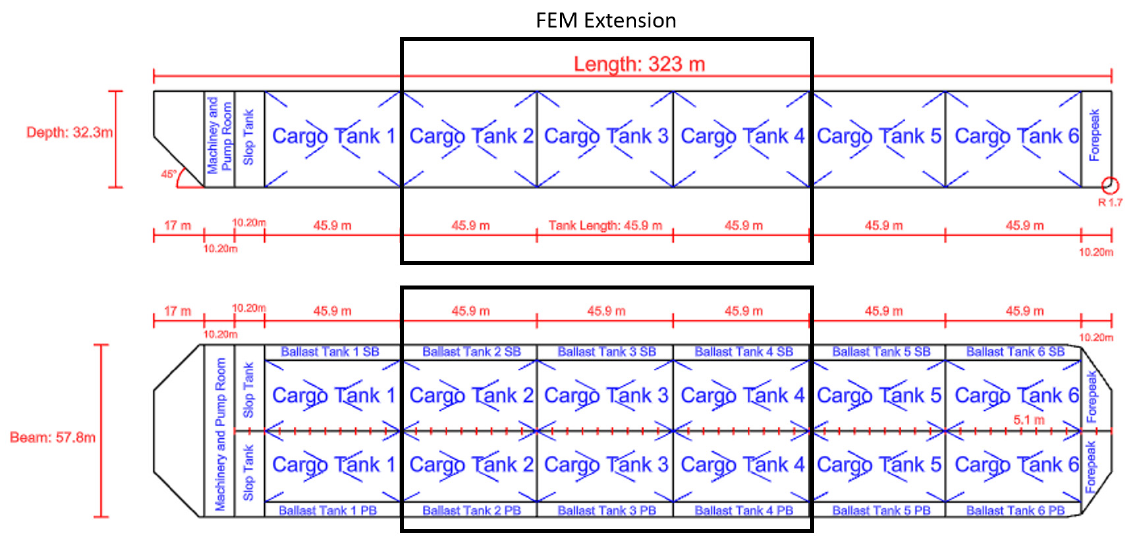
Figure 7. FEM extension considered in the study.